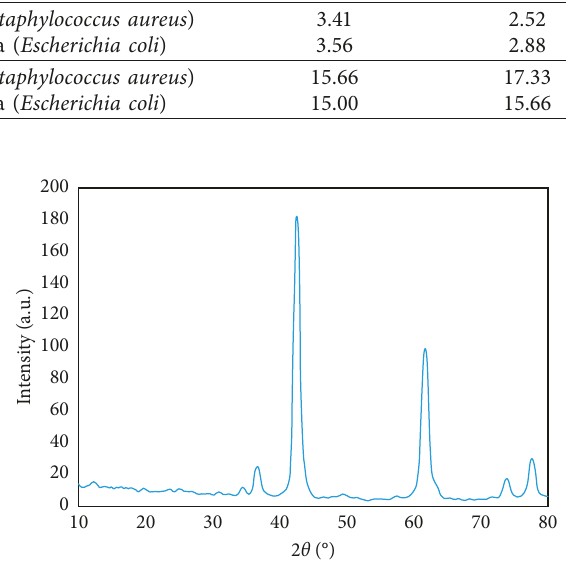
Figure 1: XRD pattern of magnesium oxide nanoparticles.